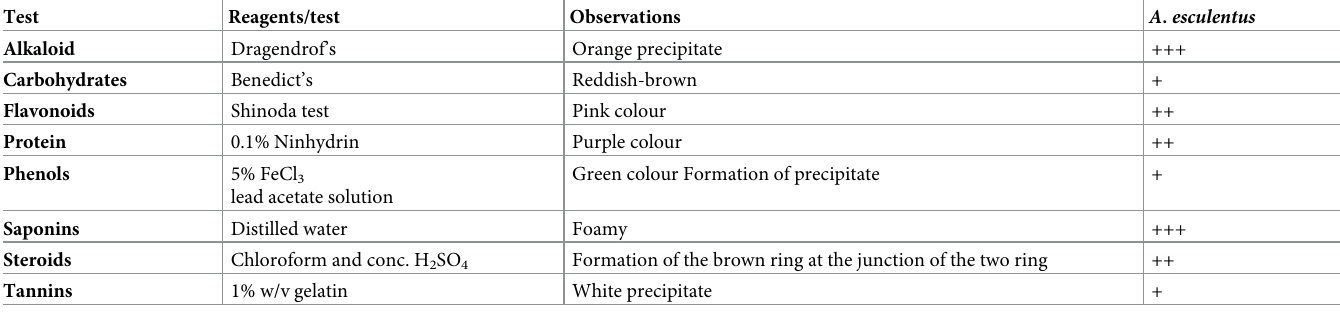
Table 4. Preliminary phytochemical